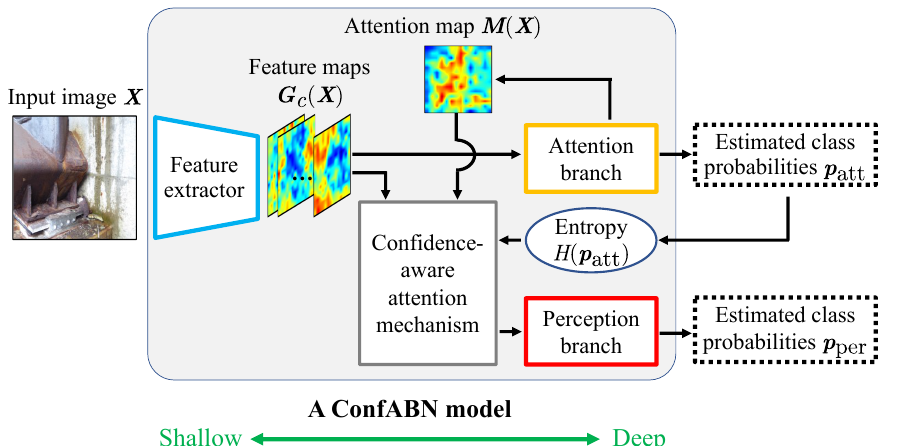
Figure 2. Overview of ConfABN. The feature extractor and attention branch of ConfABN output the feature maps and generate the attention map, respectively, in the same manner as the original ABN. The difference between ConfABN and ABN is that ConfABN uses a confidence-aware attention mechanism, which is an improved attention mechanism. Specifically, the confidence-aware attention mechanism can consider the confidence in the attention map by utilizing the entropy calculated from the estimated class probabilities of the attention branch. Consequently, the feature maps are strongly influenced by the effective attention map and weakly influenced by the ineffective attention